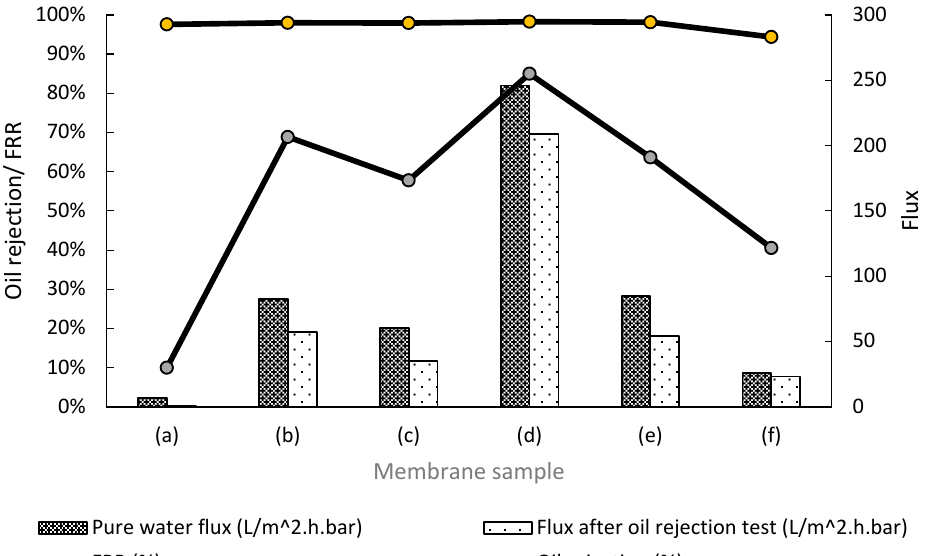
Figure 7. Pure water flux, water flux after oil rejection and flux recovery ratio of ( a ) PES 0, ( b ) PES 1, ( c ) PES 2, ( d ) PES 3, ( e ) PES 4, and ( f ) PES 5.